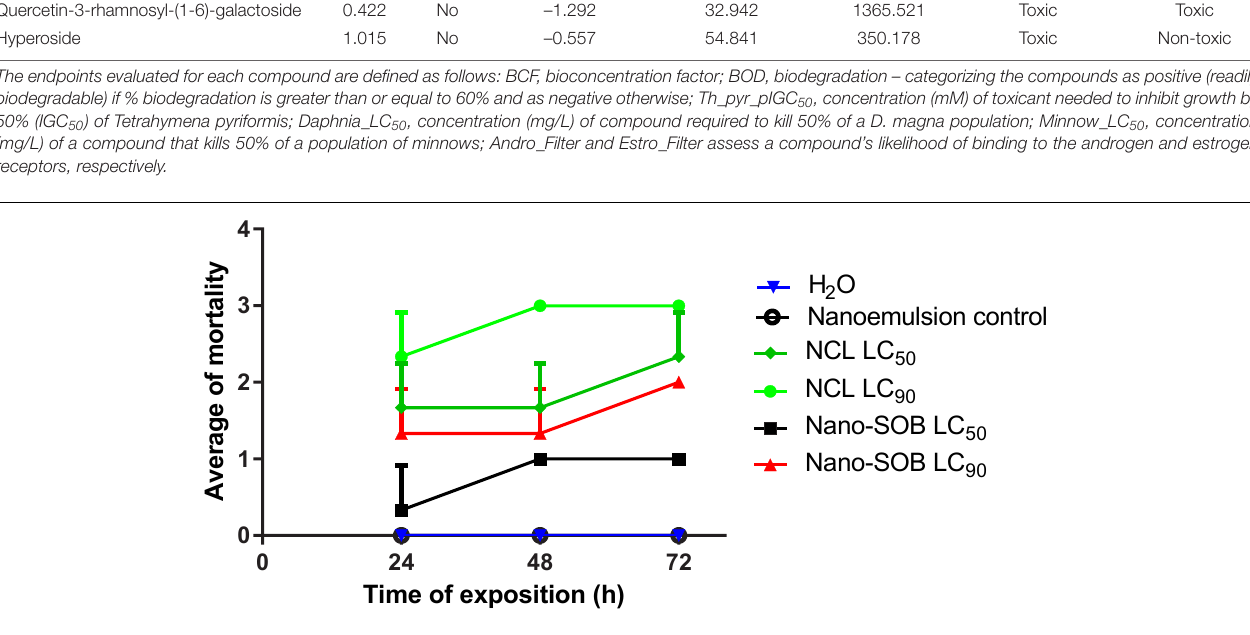
FIGURE 6 | Mortality kinetics of Melanoides sp. Tests were performed in triplicate on three different days. These data are expressed as the mean ± SD. Using the two-way ANOVA test, the value of R 2 is determined as 0.630, with a P- value of <